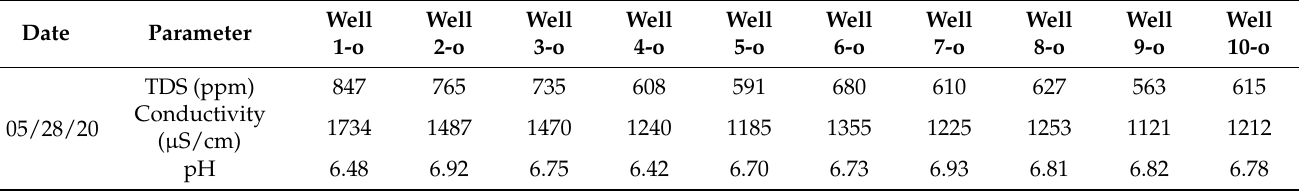
Table 1. Results of field measurements of groundwater